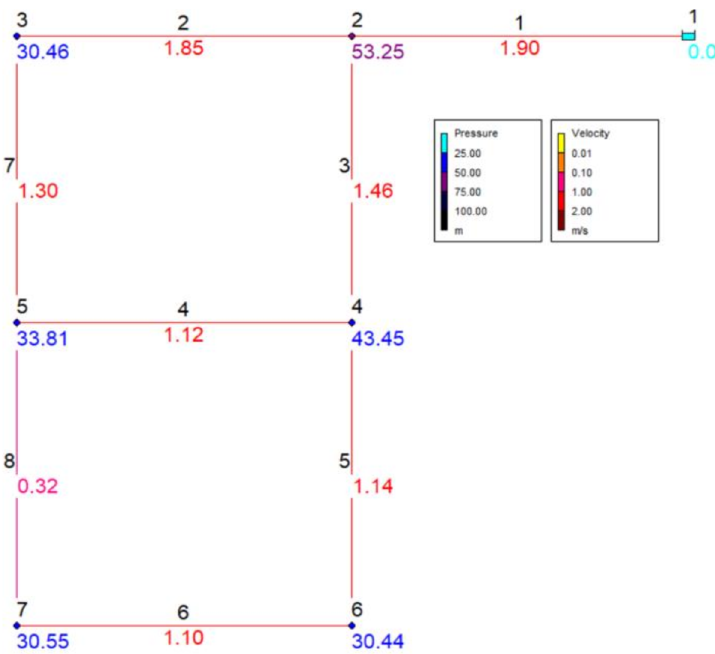
Figure 7. The Two-loop network solution obtained (pressure and velocity).